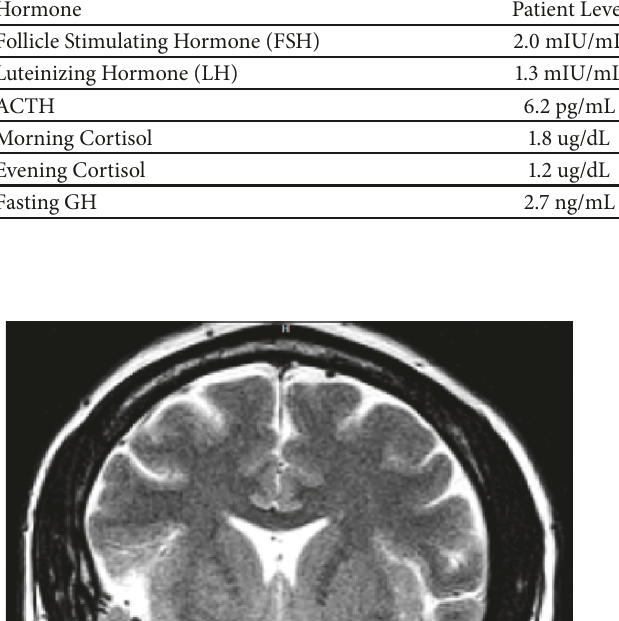
of the HPA axis secondary to a pituitary adenoma.